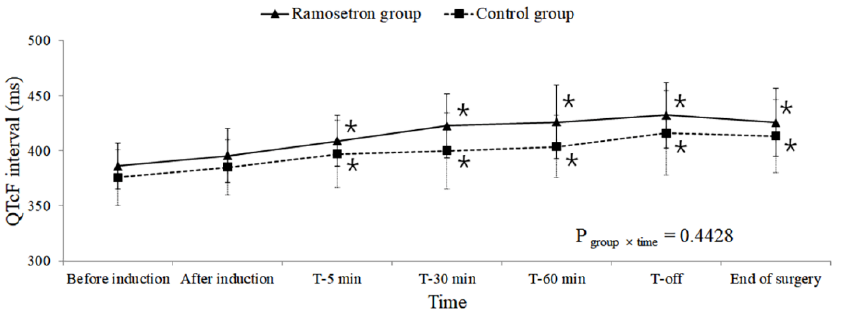
Figure 3. Changes in QTcB during robot-assisted laparoscopic prostatectomy. Values are presented as mean ± standard deviation. QTcB: Heart-rate-corrected QT intervals calculated by Bazett’s formula; T-5 min, 30 min, 60 min: 5, 30, and 60 min after assuming the steep Trendelenburg position with CO 2 pneumoperitoneum; T-off: Immediately after assuming a supine position with CO 2 desufflation. * Bonferroni-corrected p < 0.05 compared with the value before induction within each group.